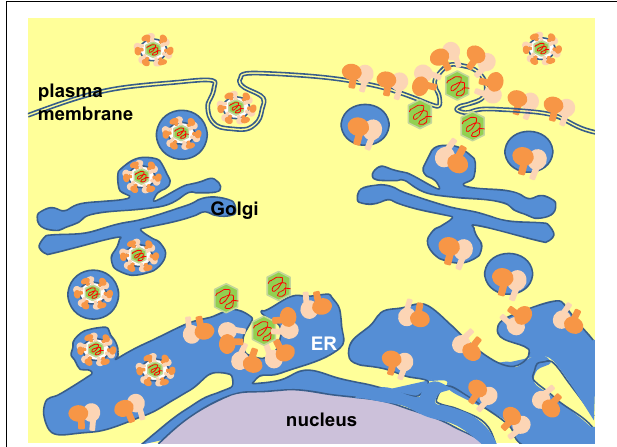
FIGURE 4 | Two modes of virus budding. Left: Virus budding into the endoplasmic reticulum (ER). Virion assembles and buds into the ER, where it is coated by the ER-resident envelope proteins. Egress of virus particle follows the host secretory pathway and released into the extracellular space. Right: Virus budding from the plasma membrane. Envelope proteins are targeted to the ER and transported to the cell surface via the host secretory pathway. Virion assembles and buds through the plasma